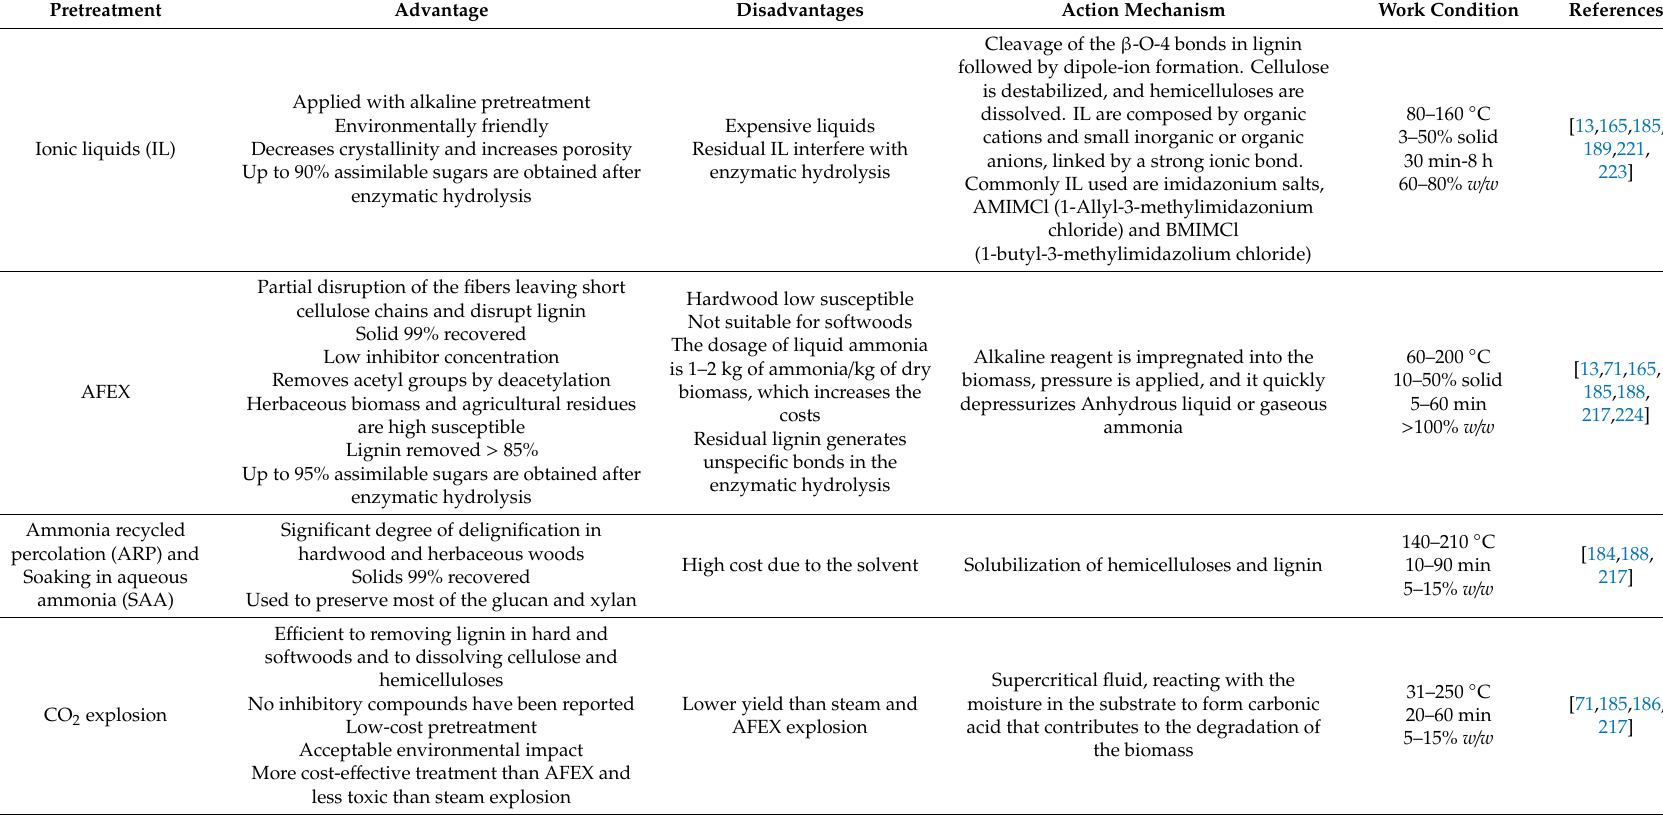
Table 2. Features of di ff erent pretreatments utilized to improve the e ffi cacity of conventional pretreatment (acid, alkaline, acid / alkaline, steam explosion and